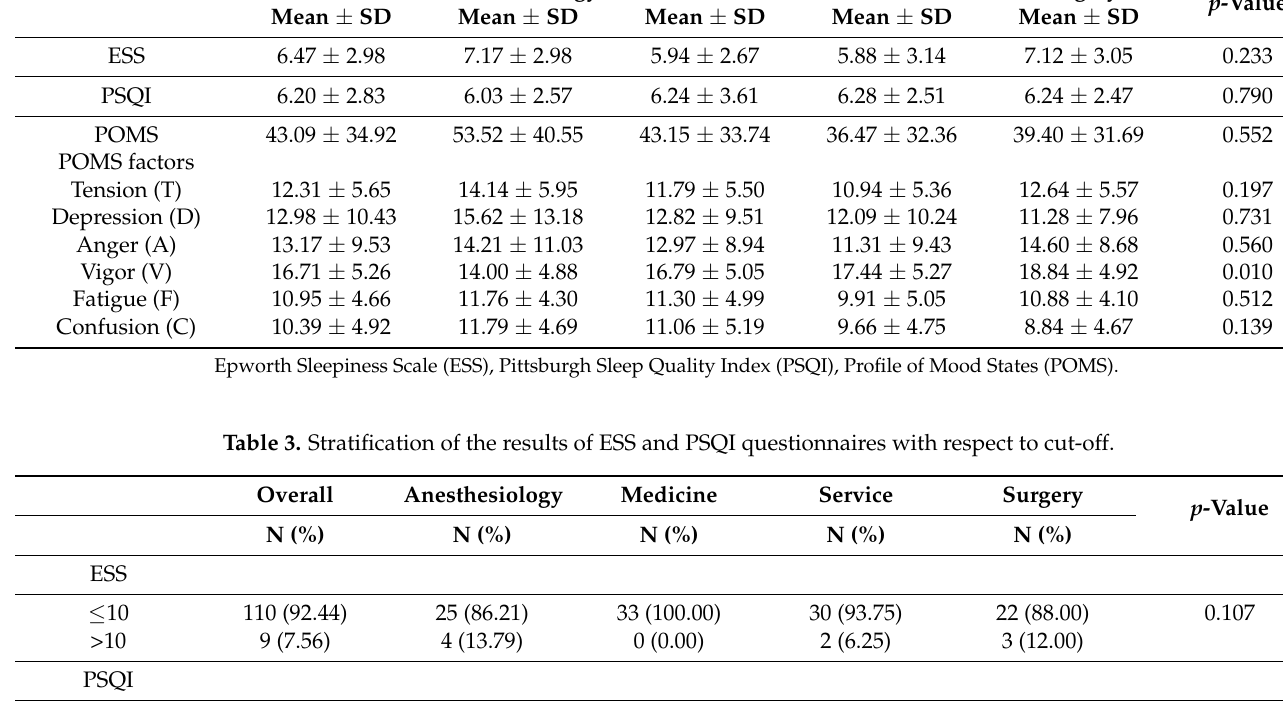
Table 2. Total score of ESS, PSQI, and POMS questionnaires (Mean ± SD). Overall Anesthesiology Medicine Service Surgery